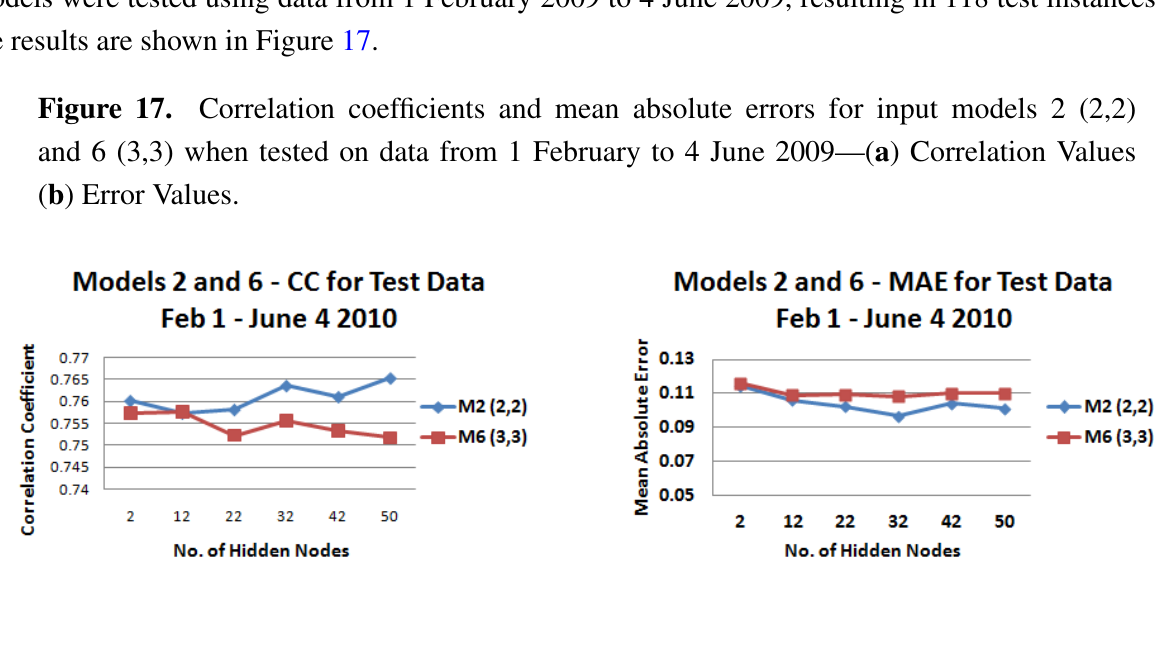
Figure 18. Correlation coefficients and mean absolute errors for input model 2 (2,2) when tested on data from individual months—February, March, April, May—( a ) Correlation Values ( b ) Error